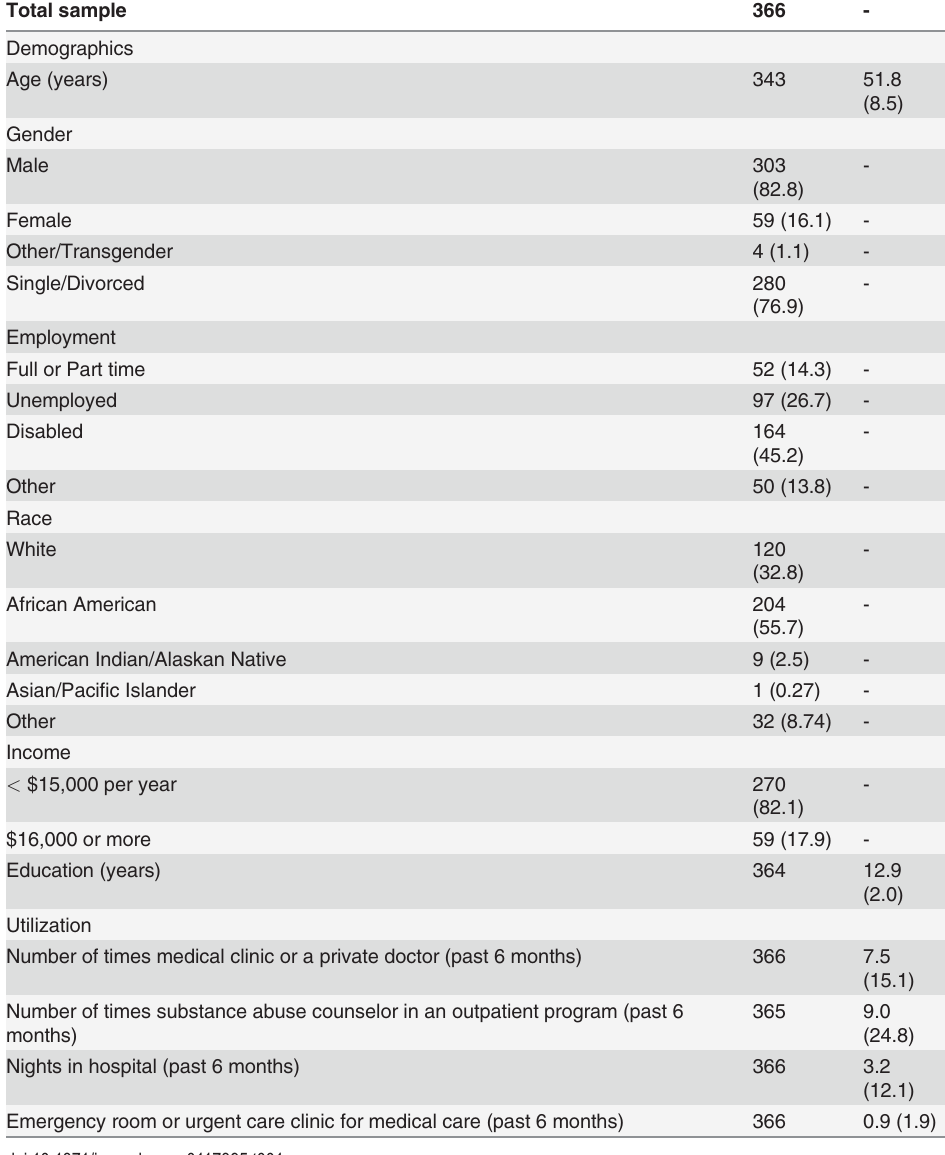
Table 1. PCQ-H sample population demographics across fi ve clinic